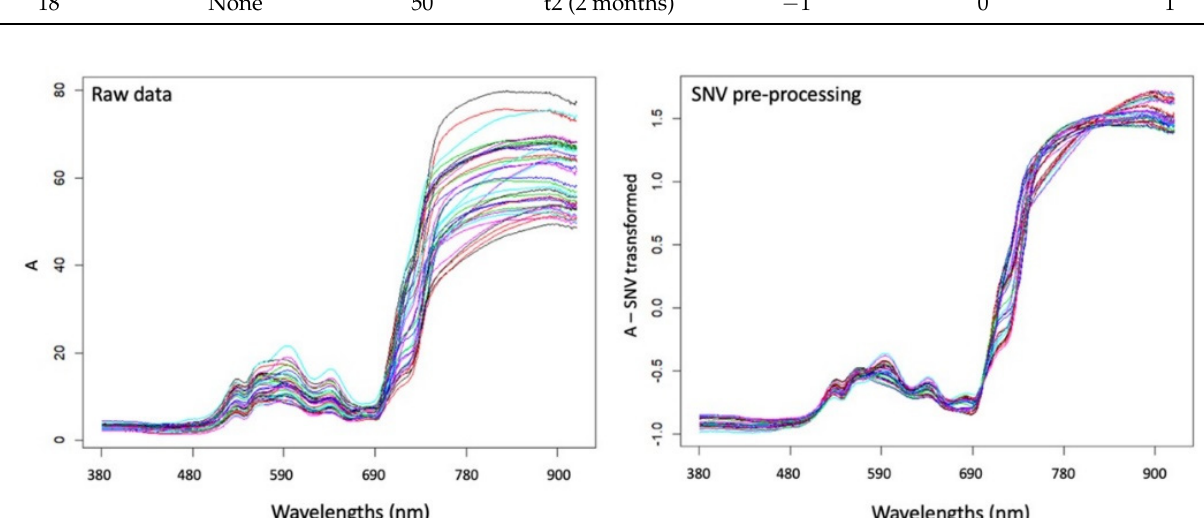
Figure 2. The spectra before and after SNV normalization.